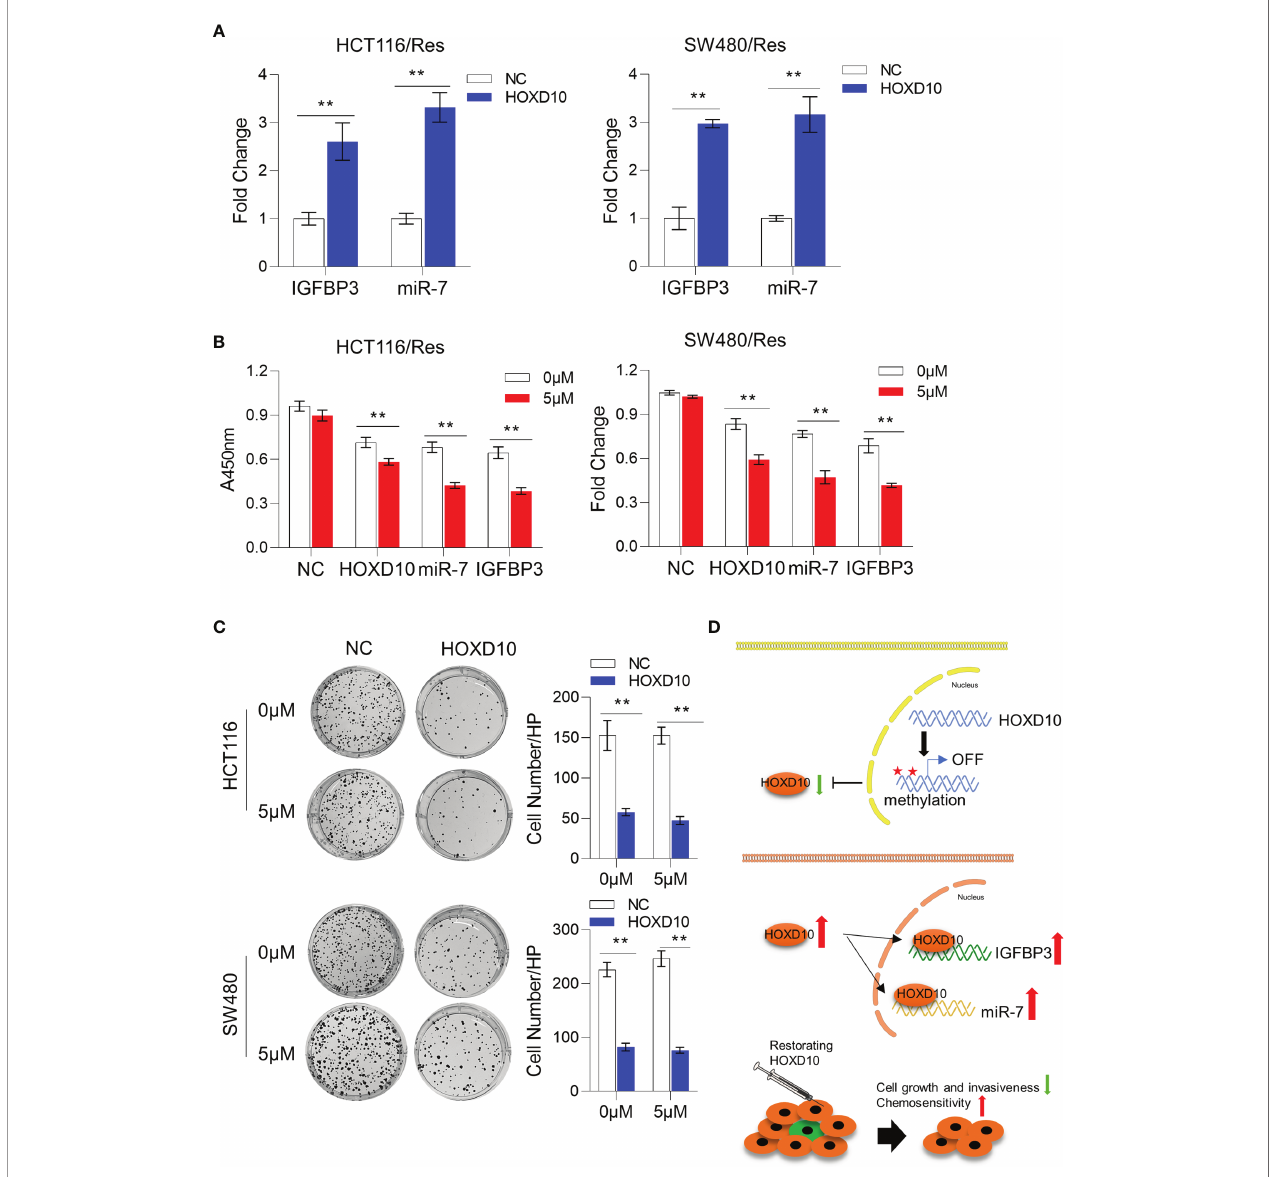
FIGURE 6 | Restoration of HOXD10 in resistant cells enhanced chemosensitivity through miR-7 and IGFBP3. (A) Relative expressions of miR-7 and IGFBP3 in resistant colorectal cancer cells with HOXD10 overexpression or control cells. ** p < 0.01 (independent t -test comparing control and HOXD10 -expressing cells). (B) CCK-8 assay showed the cell viability of resistant cells with HOXD10 , miR-7, or IGFBP3 overexpression under treatment with 5 m g/ml 5- fl uorouracil (5-FU). ** p < 0.01 (independent t -test). (C) Colony formation assay showed that resistant cells expressing HOXD10 showed a signi fi cantly reduced number of colonies compared to control cells in either absence or presence of 5-FU. ** p < 0.01 (independent t -test). (D) Schematic illustration showing that HOXD10 is frequently methylated, silenced, and contributes to the development of colorectal cancers. The re-expressed HOXD2 directly regulates the expressions of both miR-7 and IGFBP3, highlighting that the restoration of HOXD10 with concurrent 5-FU-based chemotherapy may be a potential treatment option for patients with